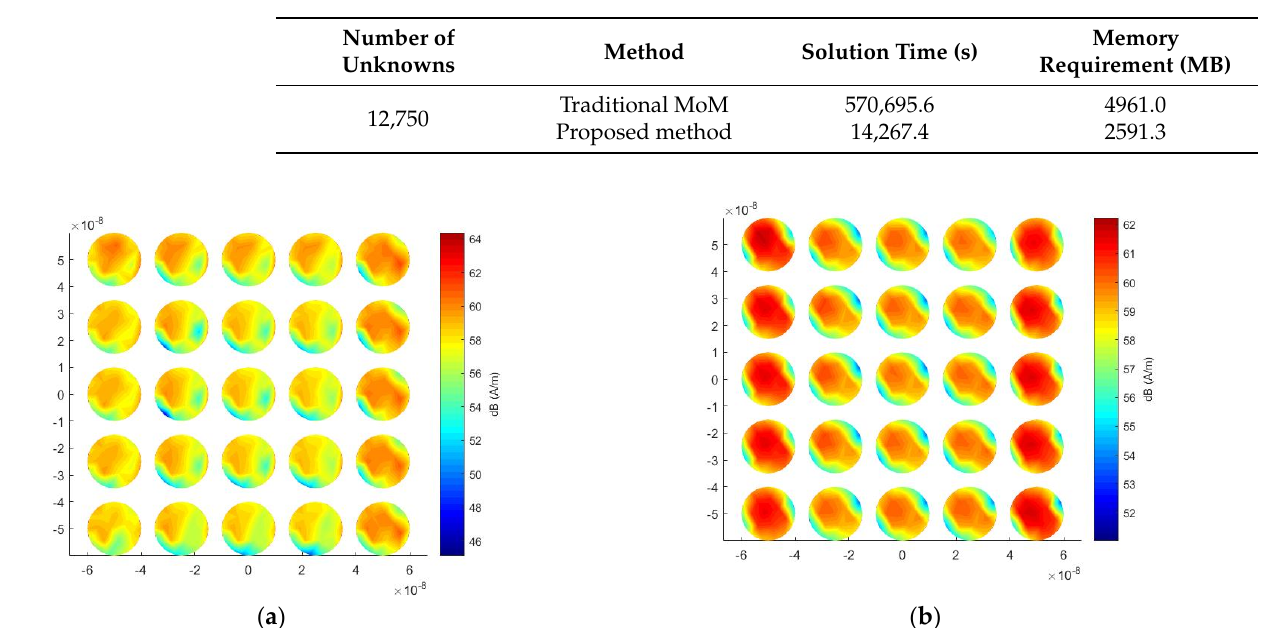
Table 2. Comparison of the computational costs between the proposed method and the traditional MoM for the nanocylinder array.